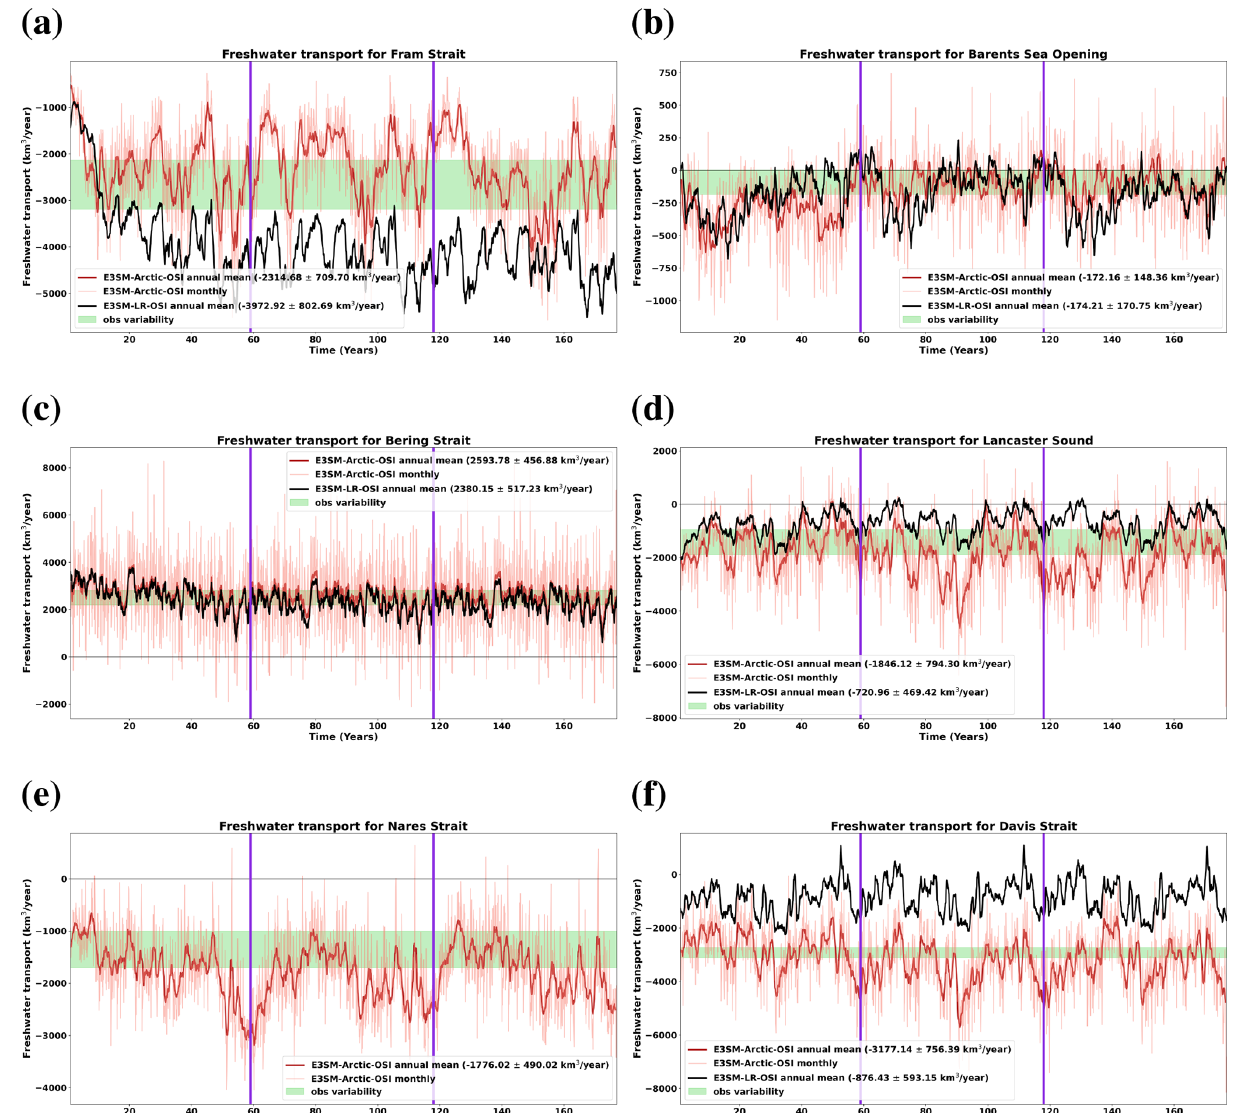
Figure 9. Similar to Fig. 7 but for net freshwater transport, where freshwater is computed with respect to the reference salinity of 34 . 8psu. Observational values are − 2660 ± 528km 3 yr − 1 for the Fram Strait and − 90 ± 94km 3 yr − 1 for the BSO (see Serreze et al., 2006, for both estimates), 2500 ± 300km 3 yr − 1 for the Bering Strait (Woodgate and Aagaard, 2005), between − 1900 and − 950km 3 yr − 1 for the Lancaster Sound (Prinsenberg and Hamilton, 2005), between − 1700 and − 1000km 3 yr − 1 for the Nares Strait (Münchow, 2016), and − 2930 ± 190km 3 yr − 1 for the Davis Strait (Curry et al.,